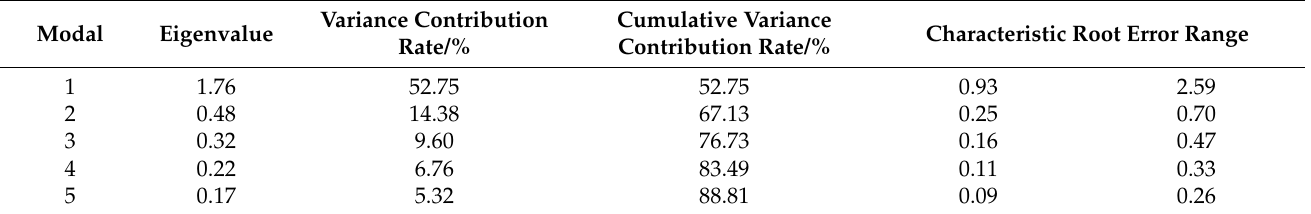
Table 2. The contribution rate of the first five eigenvectors of EOF decomposition of Xilin Gol annual effective drought index.